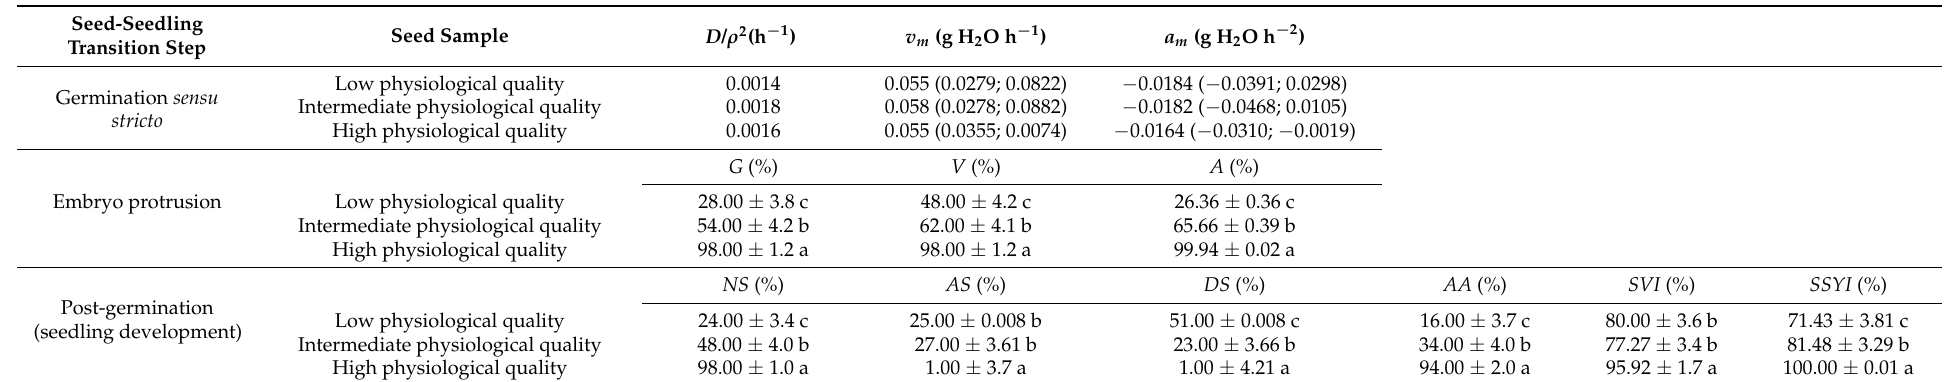
Table 1. Seed-seedling transition measurements in soybean ( Glycine max